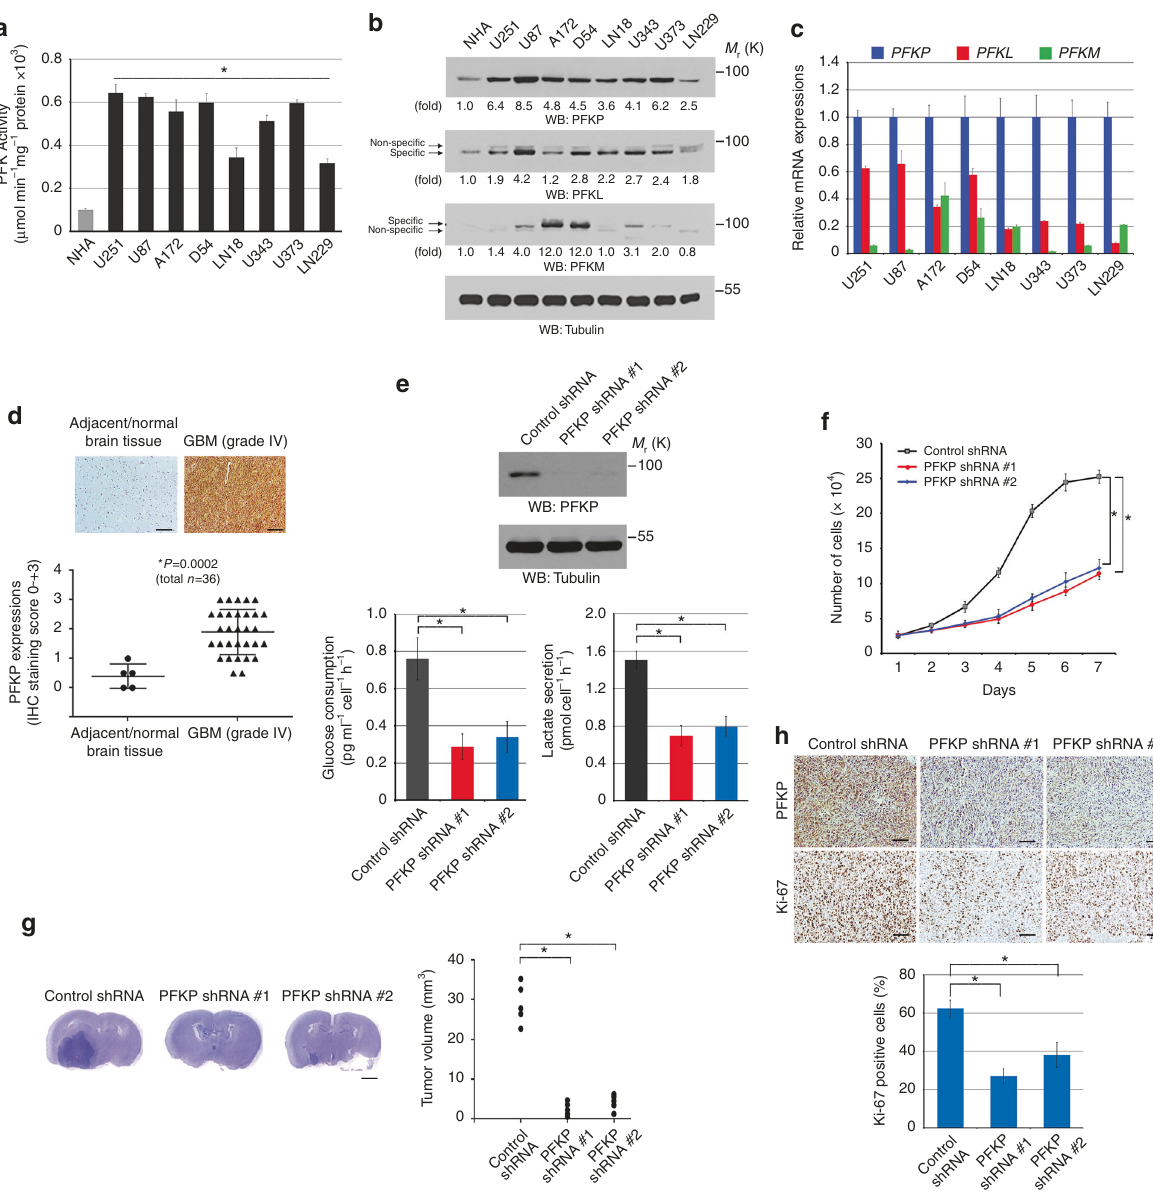
Fig. 1 PFKP expression is required for the Warburg effect and brain tumor growth. a PFK enzymatic activity was measured in normal human astrocytes (NHA) and the indicated GBM cells. Data represent the means ± s.d. of three independent experiments. * P < 0.001, based on the Student ’ s t test. b The protein expression levels of PFK1 isoforms in NHA and the indicated GBM cells were determined by immunoblotting analyses with the indicated antibodies, respectively. c Relative mRNA expression levels of PFK1 isoforms were determined. The results were based on those in Supplementary Fig. 1a, c. d Microarrays of human GBM and normal brain tissue were immunostained with an anti-PFKP antibody. Representative images are shown (top panel). Data represent the means ± s.d. (bottom panel). * P < 0.001, based on the Student ’ s t test. Scale bar, 100 μ m. e U87/EGFRvIII cells were transfected with different shRNAs against PFKP. PFKP shRNA#1 was used for the subsequent experiments (top panel). The cells were cultured in no-serum DMEM for 24 h. The media were collected to analyze glucose consumption (bottom left panel) and lactate secretion (bottom right panel). All results were normalized to the fi nal cell number. Data represent the means ± s.d. of three independent experiments. * P < 0.001, based on the Student ’ s t test. f Control U87/EGFRvIII cells or PFKP-depleted U87/EGFRvIII cells were cultured in 1% serum medium for the indicated periods of time and harvested for cell counting. Data represent the mean ± s.d. of three independent experiments. * P < 0.001, based on the Student ’ s t test. g A total of 5 × 10 5 control U87/EGFRvIII cells or PFKP-depleted U87/EGFRvIII cells were intracranially injected into athymic nude mice. After 2 weeks, the mice were euthanized and examined for tumor growth. Hematoxylin-and-eosin – stained coronal brain sections show representative tumor xenografts (left panel). Tumor volumes were measured by using length ( a ) and width ( b ) and calculated using the equation V = ab 2 /2. Data represent the means ± s.d. of 5 mice (right panel). Note that the scores of some samples overlap. * P < 0.001, based on the Student ’ s t -test. Scale bar, 2 mm. h IHC analyses of the tumor tissues were performed with anti-PFKP and anti-Ki-67 antibodies. Representative staining (top panel) and quanti fi cation of the staining (bottom panel) are shown. * P < 0.001, based on the Student ’ s t -test. Scale bar, 100 μ